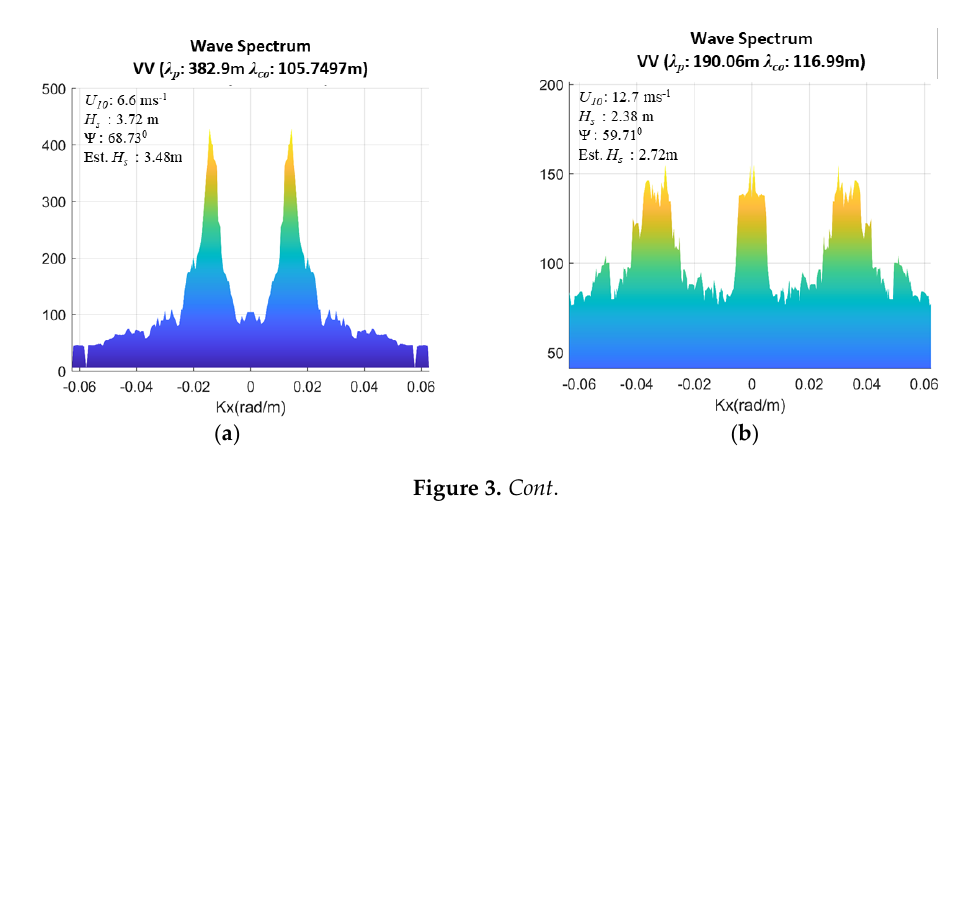
Figure 2. 5 km × 5 km subset taken from the 10 km × 10 km SAR Normalized Radar Cross Section (NRCS) of VV ( a ) and VH-polarizations ( c ) on 27 March 2017, co-located with NDBC 51000 and SAR NRCS of VV ( b ) and VH-polarizations ( d ) on 26 April 2017, co-located with NDBC 46054. 2-D wave spectrum of the SAR VV ( e ) and VH ( g ) NRCS on 27 March 2017, and spectra of the SAR VV ( f ) and VH ( h ) NRCS on 26 April 2017.